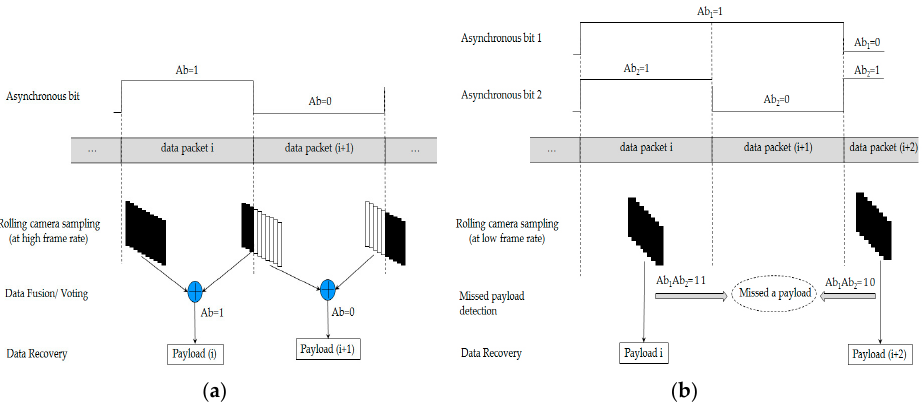
Figure 9. Decoding procedures in proposed schemes: ( a ) Data recovery method under frame rate variation without undersampling problem; ( b ) Error in grouping images during undersampling problem.